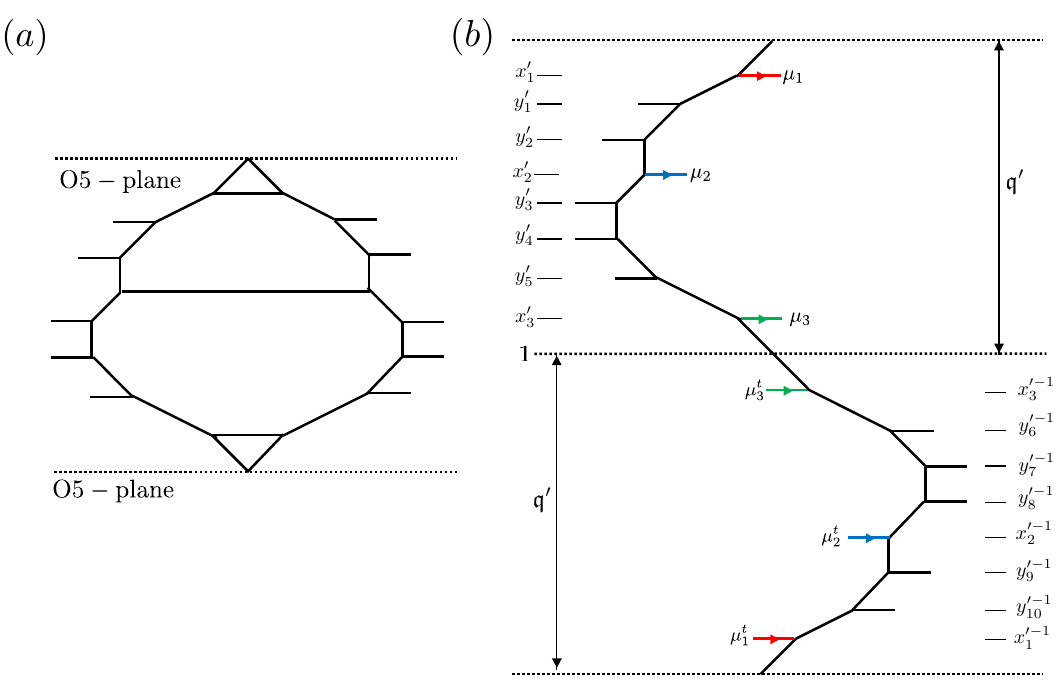
Figure 4 . A 5-brane web diagram description of 5d N = 1 Sp (2) gauge theory with 10 flavors. The dashed lines and the solid lines denote the O 5 -planes and ( p, q ) 5-branes, respectively. The variables x 0 ( I = 1 , 2 , 3) and y 0 ( i = 1 , 2 , . . . , 10) denote the position of the horizontal legs measured i I from the middle of the dashed line, and q 0 denotes the instanton